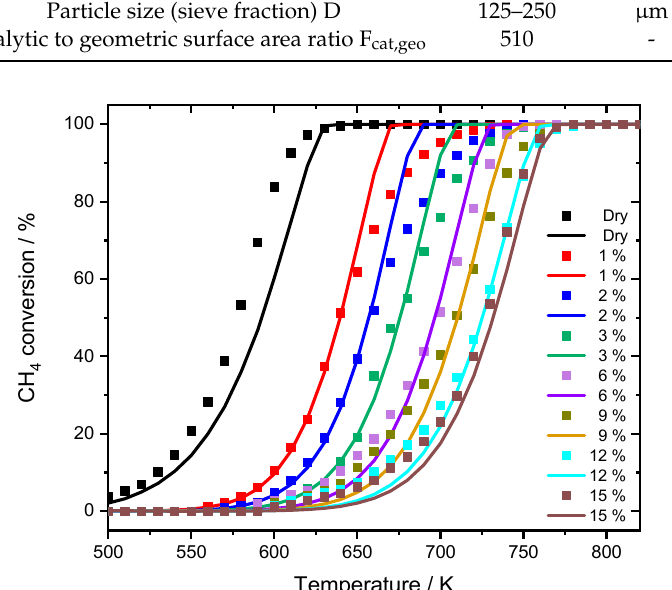
Figure 5. Comparison between experimental data (dots) and simulation results (lines) for the modified model in 3200 ppm CH 4 , 10% O 2 and balance N 2 in the absence and presence of different H 2 O concentrations. GHSV = 140,000 h − 1 .